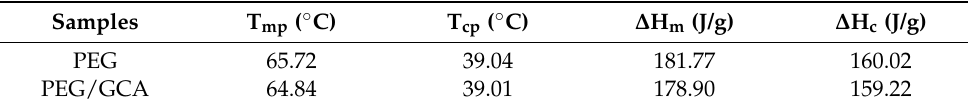
Figure 8. ( A ) Result of GCA flexibility test, ( B ) photographs of form stable test for PEG/GCA, ( C ) photographs of compression test for PEG/GCA, ( D ) PCM weight fraction of the microencapsulated PEG and PEG/GCA composites ( E ) SEM image of GCA, and ( F ) DSC results of the pure PEG and PEG/GCA composite. Table 2. DSC results of the GCA supported PCM composites.